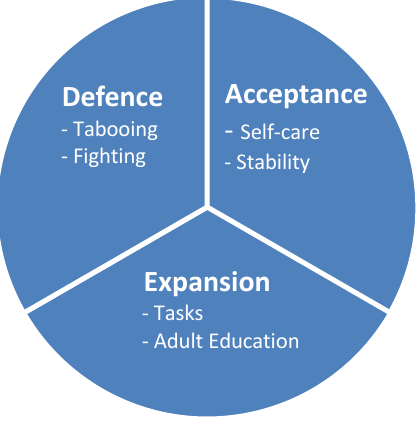
Figure 1: Strategies for dealing with ageing and limited lifetime (own